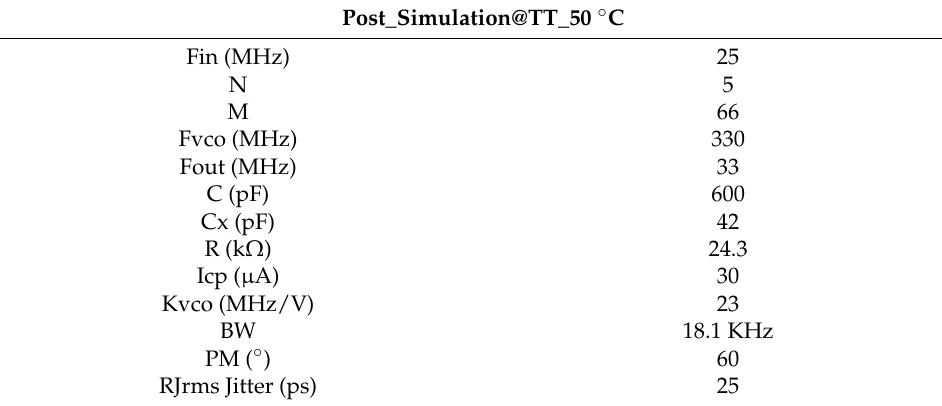
Table 1. Summary of PLL post-simulations.